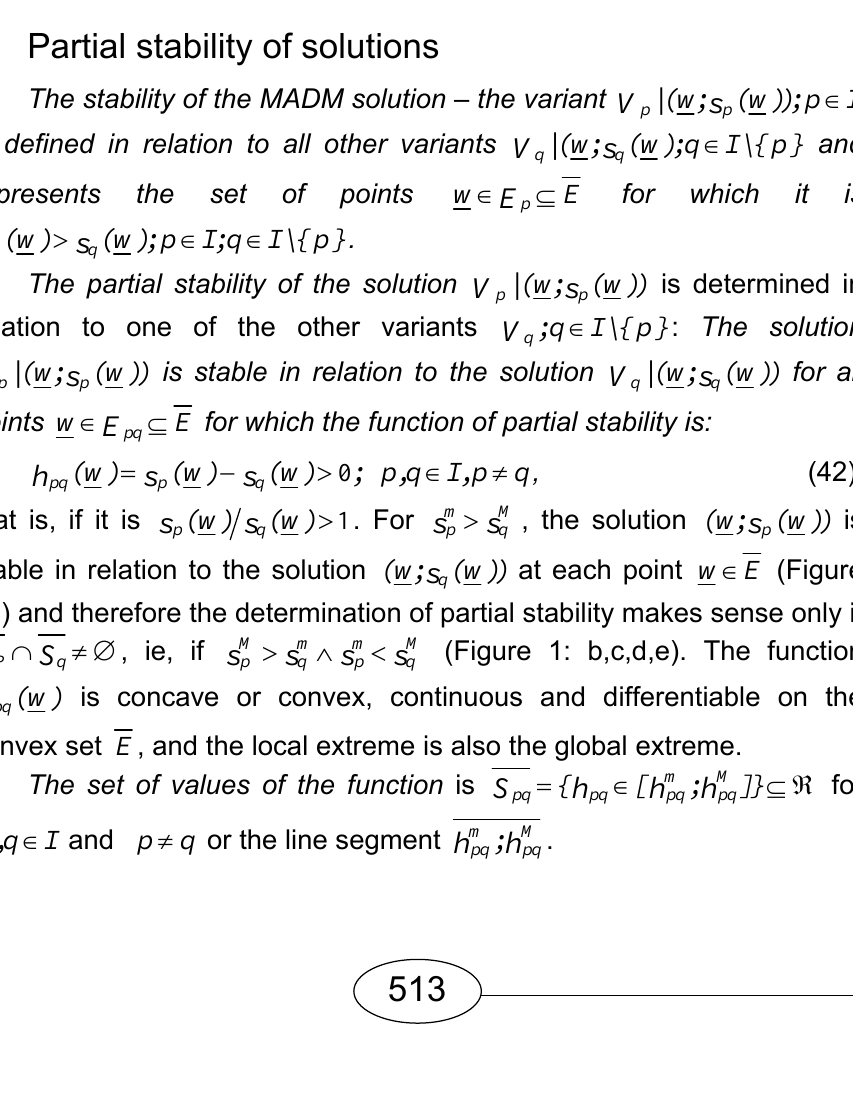
(Figure 1: b,c,d,e). The